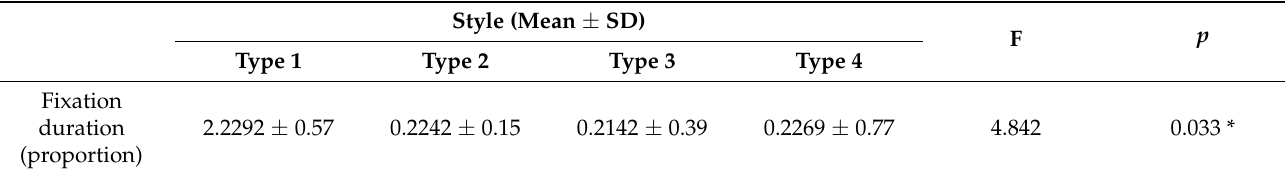
Table 12. Analysis of variance for different styles of button fixation